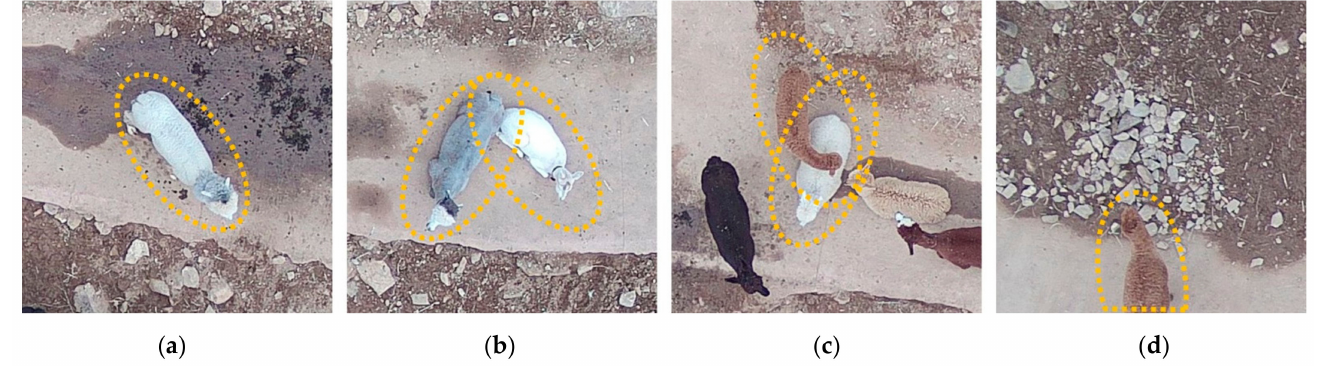
Figure 2. Target shape categories: ( a ) isolated, ( b ) bordering, ( c ) overlapping, and ( d ) partial.